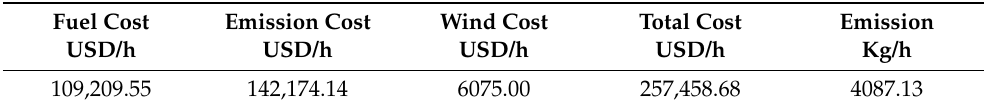
Table 34. Table of costs and emissions.